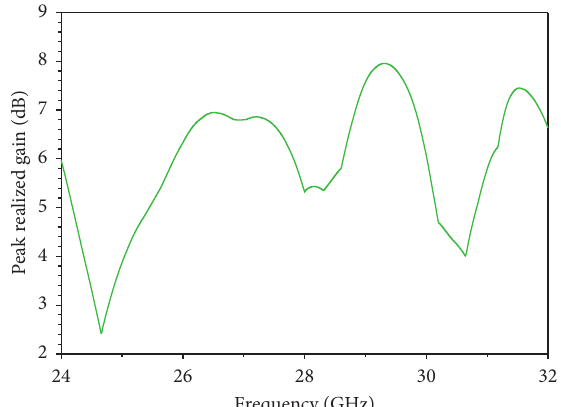
Figure 4: Peak realized gain of series-fed microstrip array